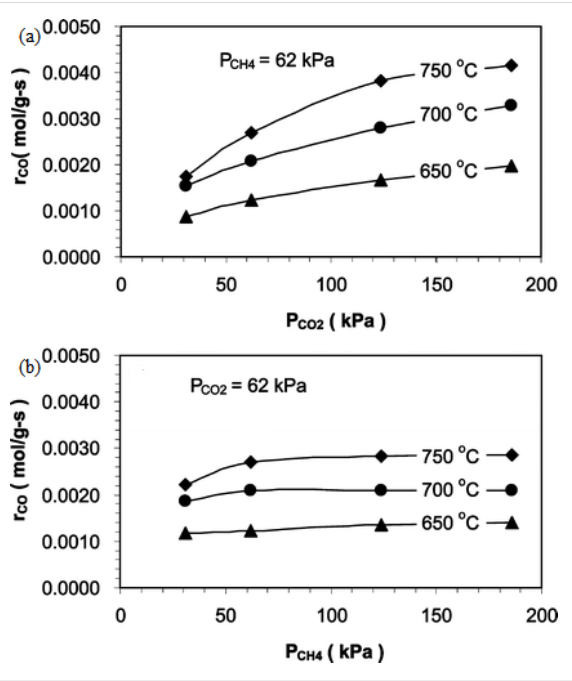
Figure 6: The reforming rates of DRM over the Ni–Co/Al–Mg-O cata- lyst affected by the (a) CO 2 partial pressure and (b) CH 4 partial pres- sure at different temperatures. Reprinted from [86], copyright 2009 American Chemical Society.